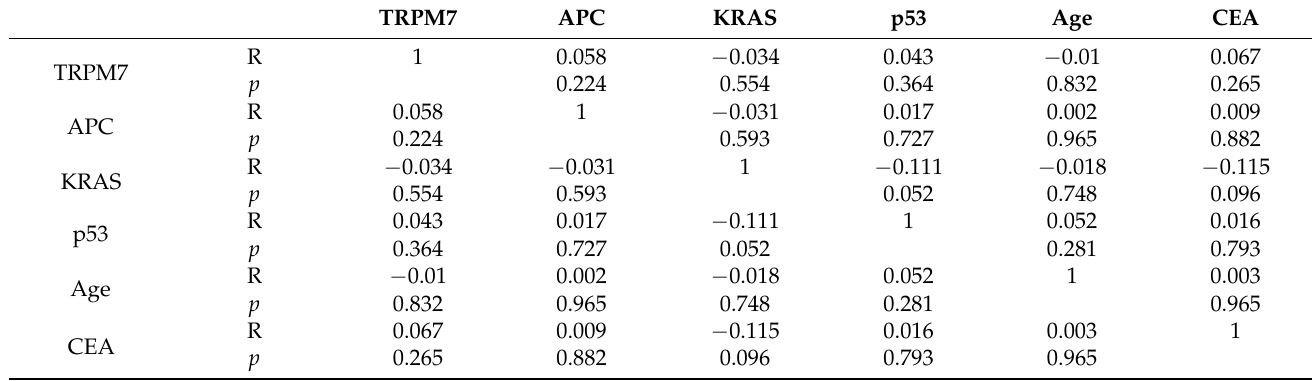
Table 3. Correlation analysis in colon